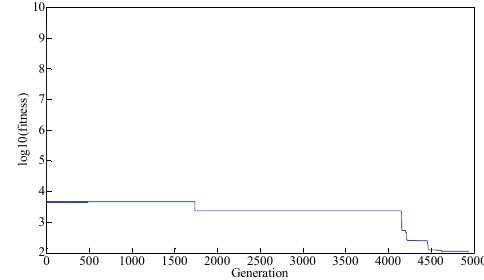
Fig.3. Fitness of best-individual generation by